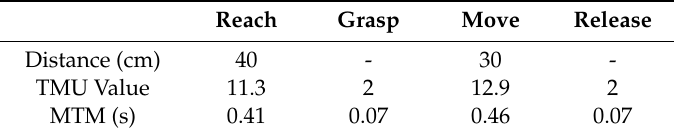
Table 7. TMU values for the simple actions: Reach, grasp, move and release. MTM: Method-Time Measurement.